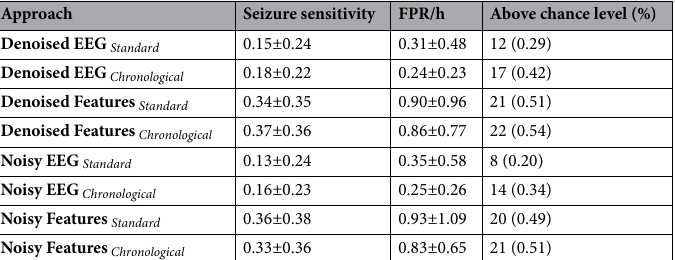
Table 2. Average results of the seizure prediction models for all approaches, for all 41